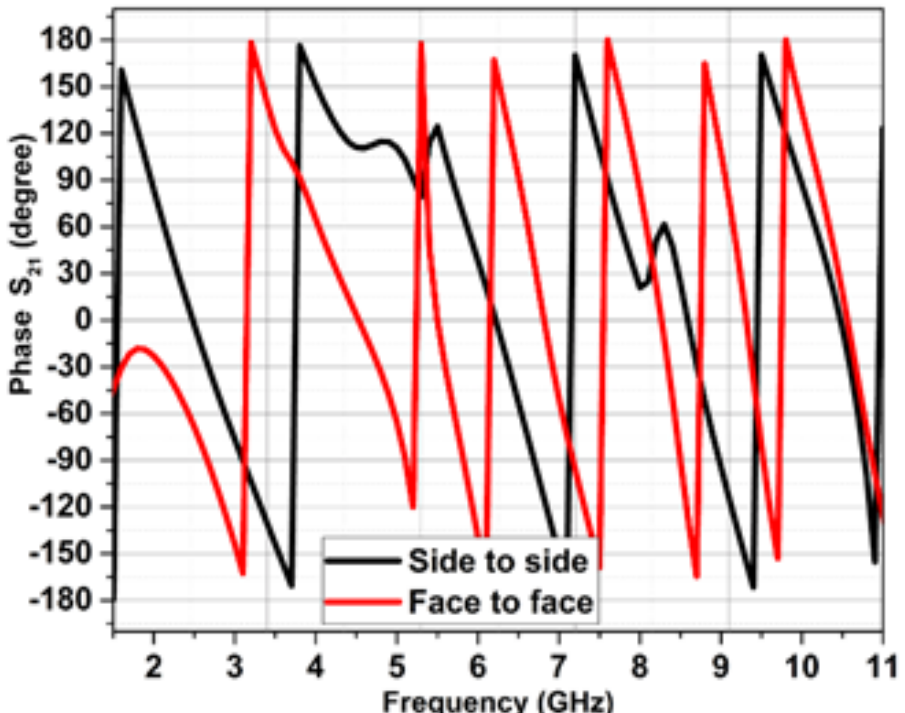
Figure 26. Phase response S 21 of the proposed UWB notch antenna.